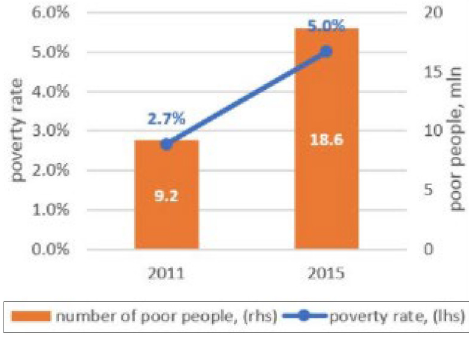
Figure 2. Extreme